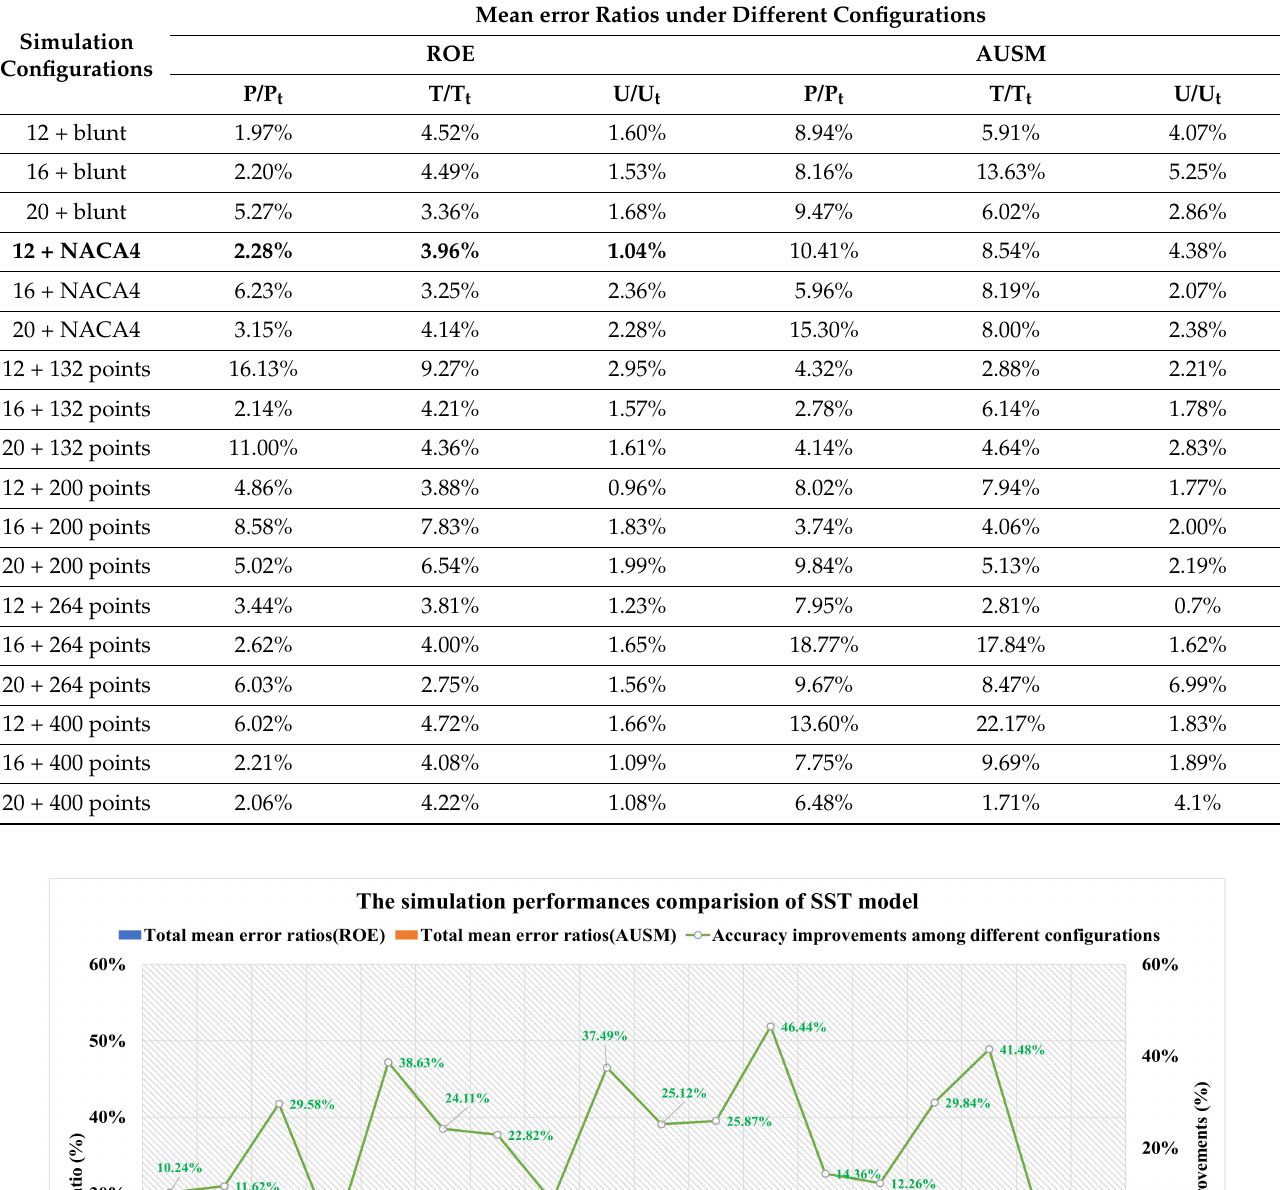
Table 21. The mean error ratios of P/P t , T/T t , and U/U t of the SST k-omega turbulence model.